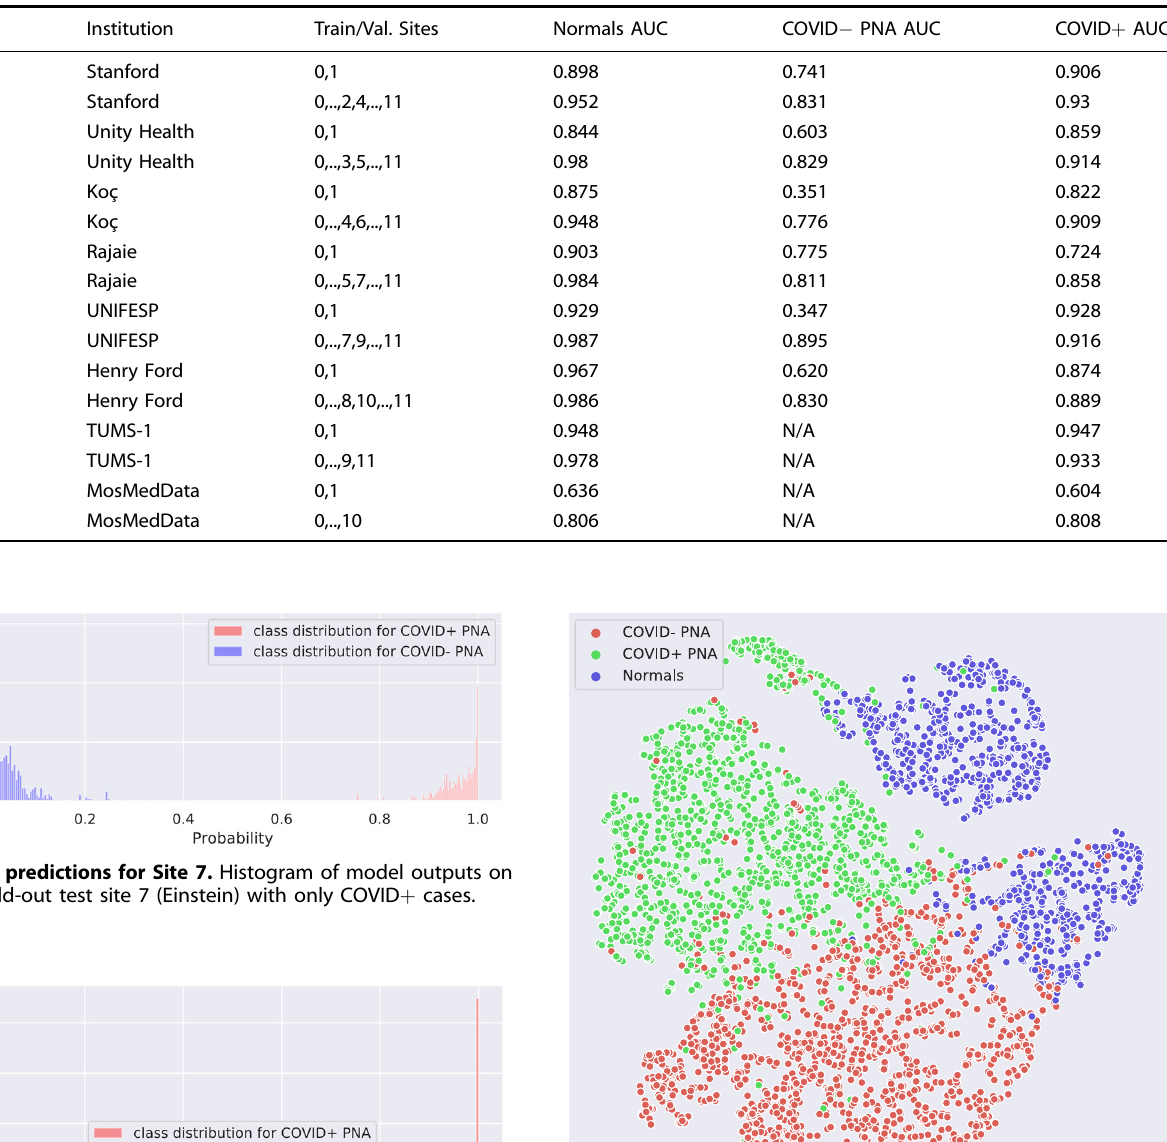
Table 2. Performance of model trained on sites 0 and 1 versus a model trained on all sites.